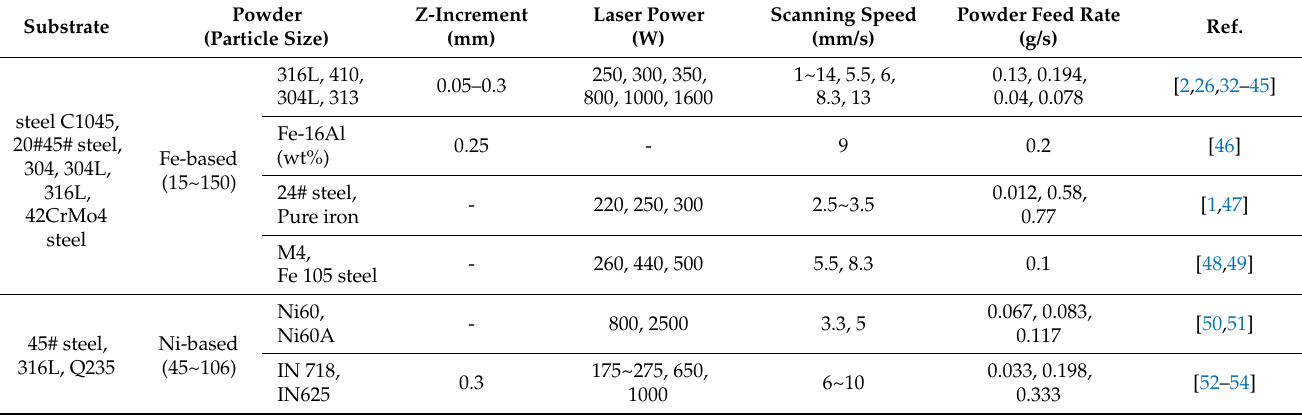
Table 1. Summary of materials used in metal thin-wall by laser material